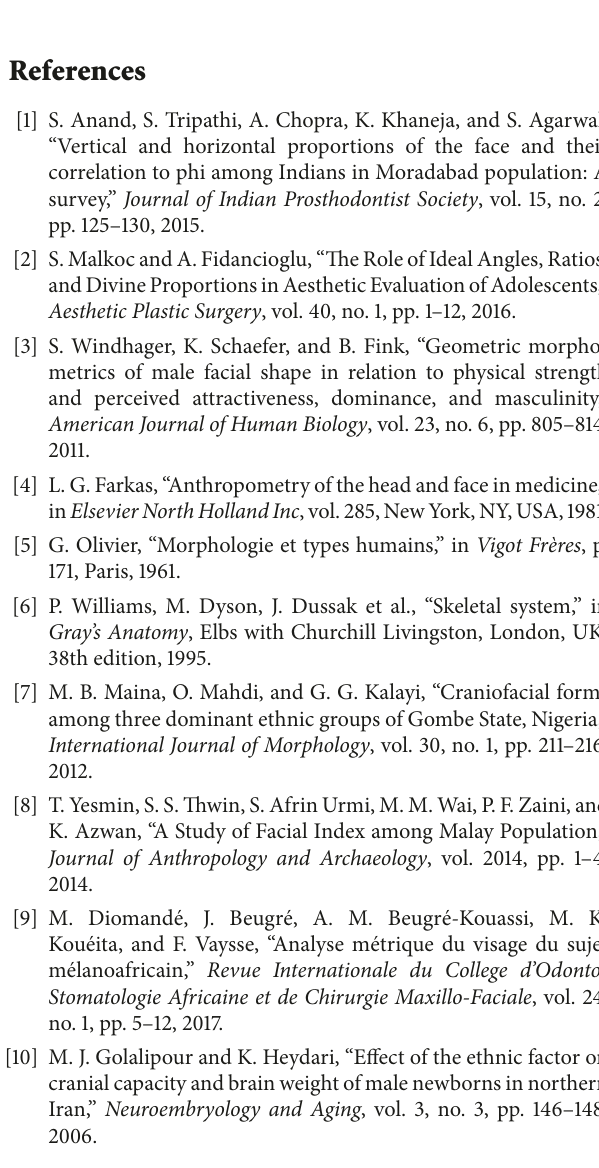
Figure 5: Regression curve of the facial index and Zy.r-Tr-Zy.l angle correlation.